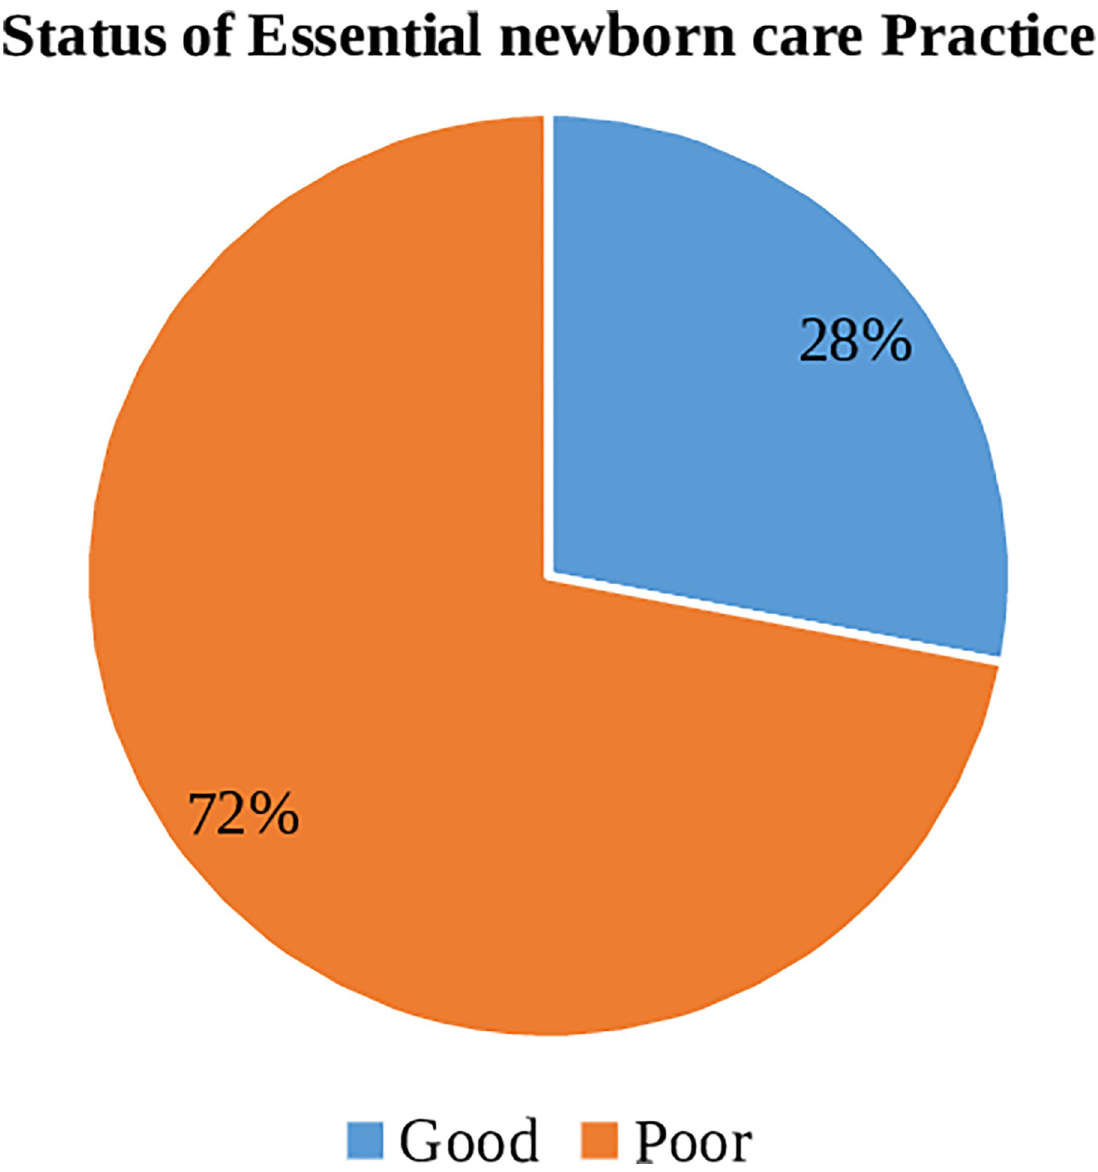
Fig 2. Prevalence of essential newborn care among home delivered post-partum women in Guto Gida district, Oromia regional state, Ethiopia, May 2020.